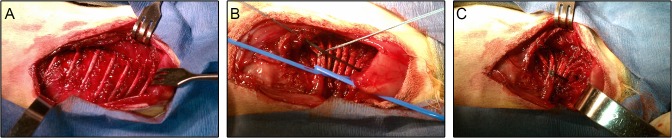
Tethering surgery.Tethering ribs 3–9 comprising the right hemithorax: (A) longitudinal incision exposing ribs; (B) ribs constricted with blue vessel loop; (C) polyester suture tied off to maintain constriction of right hemithorax, vessel loop removed.